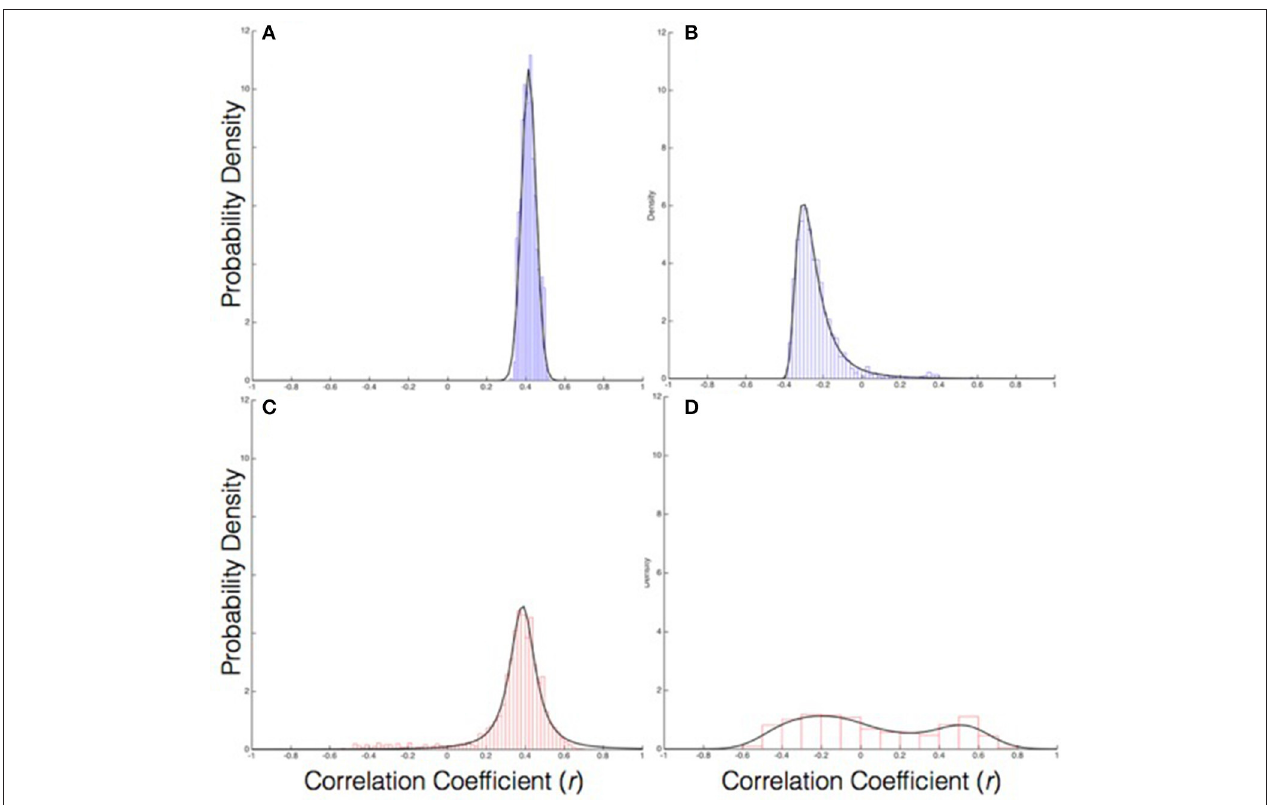
FIGURE 5 | The probability distribution of PC coefficients (r) for the speed variable: (A) Real group PC1, (B) Real group PC2, (C) Virtual group PC1, (D) Virtual group PC2.